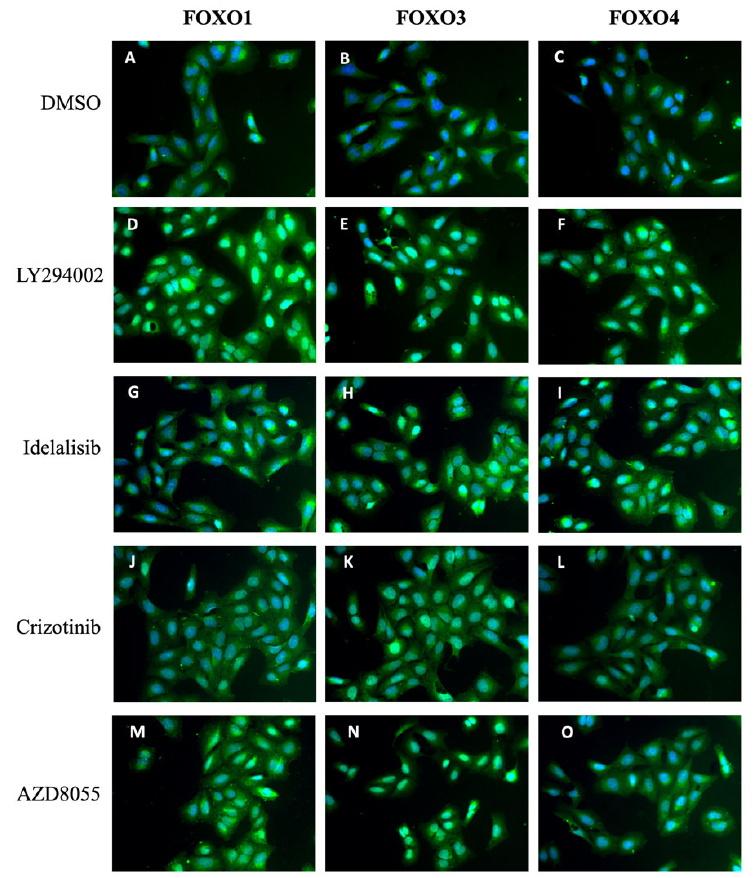
Figure 6. Effect of PI3K and mTOR inhibitors on FOXO1 and FOXO4 localization. U2OS cells were cultured and treated for 1 h with ( A – C ) 0,5% DMSO as negative control, ( D – F ) 25 μ M LY294002 as positive control or 1 μ M ( G – I ) idelalisib, ( J – L ) crizotinib, ( M – O ) AZD8055. Fixed cells were incubated with green fluorescent specific antibodies against FOXO1, FOXO3 or FOXO4 isoforms, and imaged with fluorescence microscopy. Representative images taken at 20× magnification are shown.